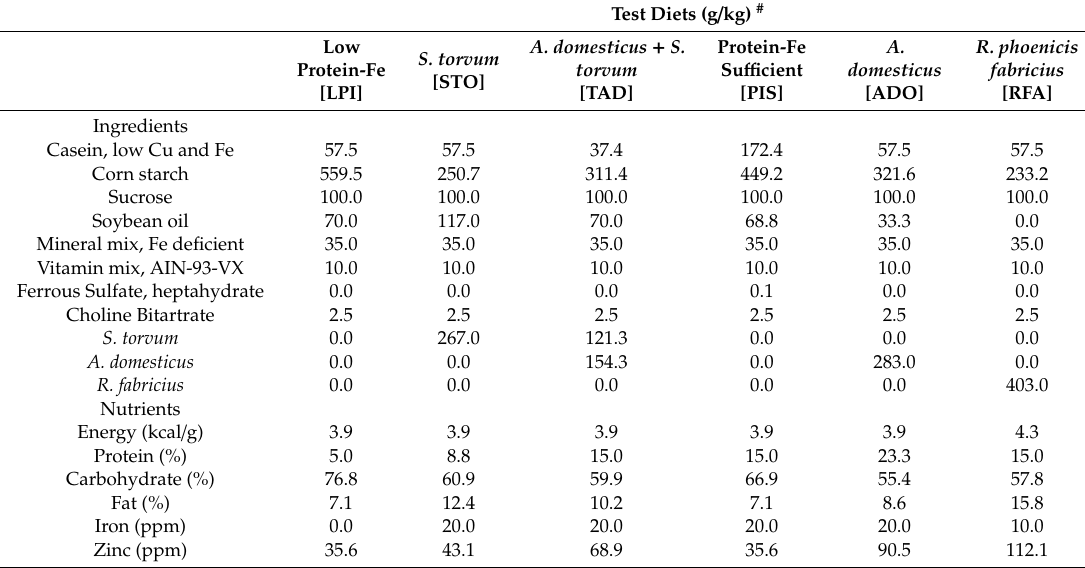
Table 1. Composition of test